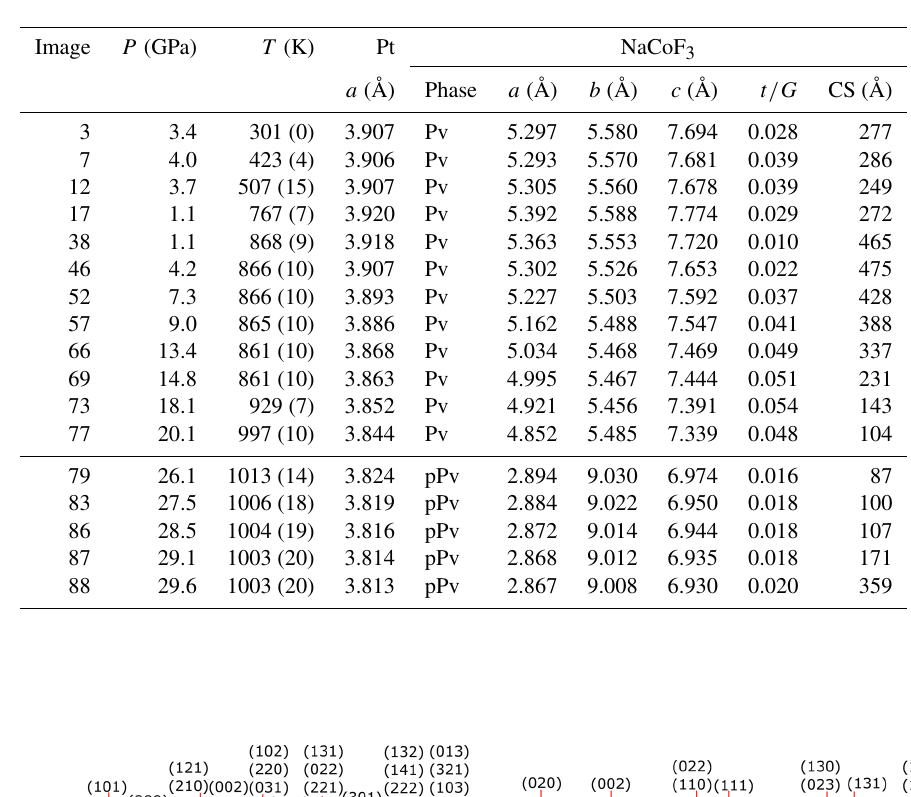
Table 1. Image number, pressure ( P ), temperature ( T ), lattice parameters, normalized stress, and crystallite size (CS) measured in the experiment. Numbers in parenthesis for temperatures are uncertainties on the last digits, determined from the difference in readings of both thermocouples. Errors are estimated to be 0.07 and 0.1Å 3 for perovskite and post-perovskite unit cell volumes, respectively, 0.002Å for unit cell parameters, 0.0002 for normalized stresses, and approximately 200Å 3 for crystallite sizes. NaCoF 3 perovskite cell parameters are displayed in the Pbnm space group.